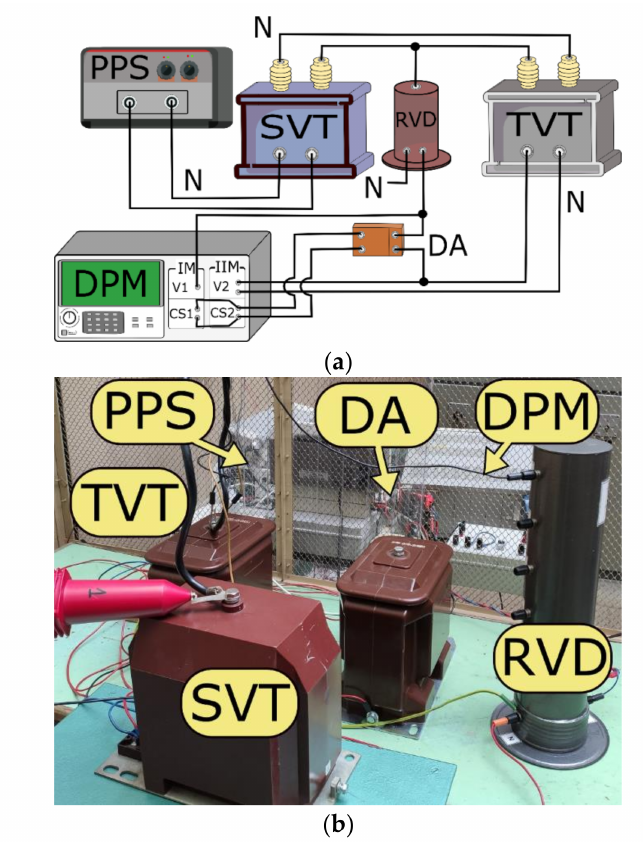
Figure 2. The measuring system: ( a ) schematic diagram, ( b ) photo of the laboratory